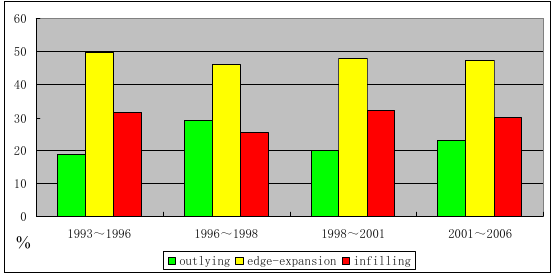
Figure 3. Patch counts of three landscape expansion types in different